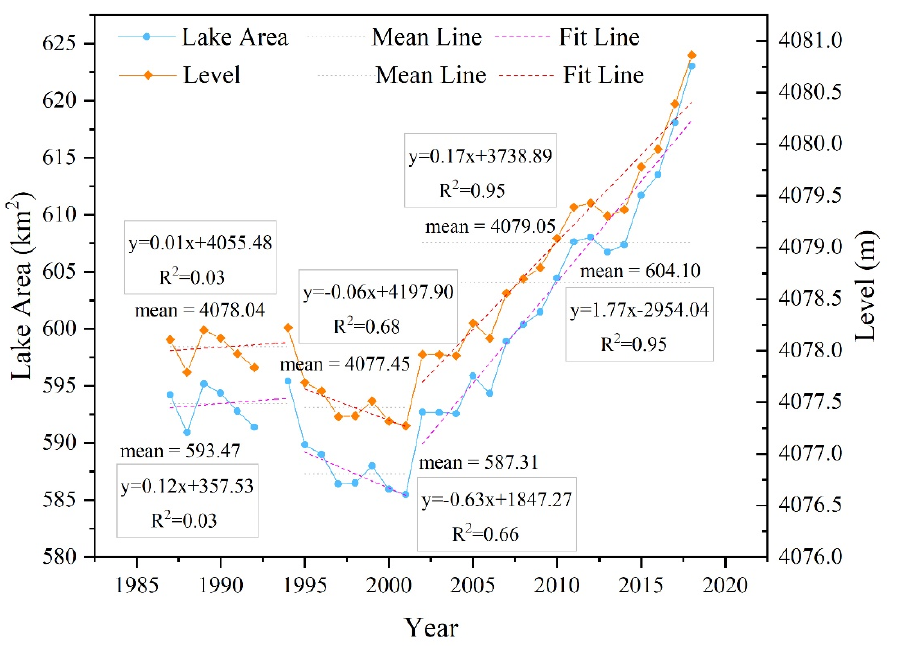
Figure 4. The water area and level of Hala Lake during 1987–2018.